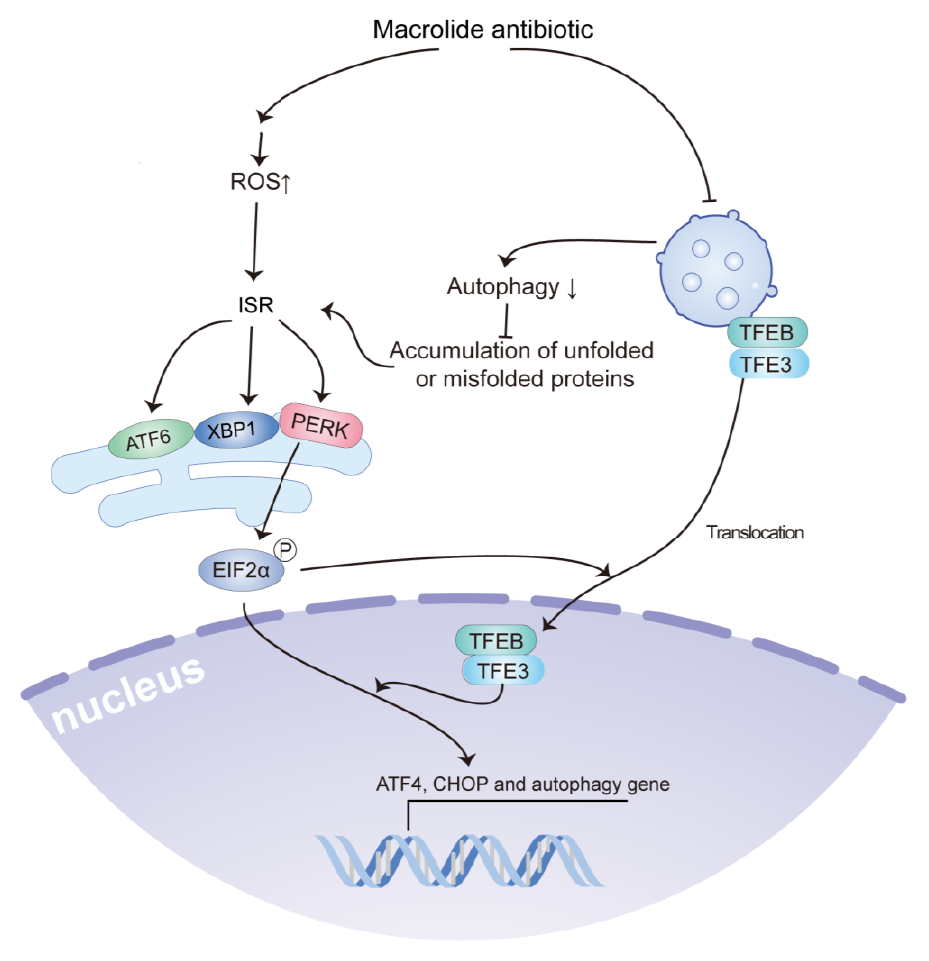
FIGURE 7: Overview of macrolide antibiotics activate the ISR. Macro- lide antibiotics inhibit lysosomal acidification, leading to the blockade of autophagic flux and the accumulation of unfolded or misfolded proteins. Moreover, they induce the accumulation of ROS. The combined accumulation of unfolded/misfolded pro- teins and ROS induces an ISR, including the activa- tion of PeIF2α/ATF4/CHOP signaling, XBP1 splicing, and ATF6 translocation, which in turn contribute to the translocation of TFEB and TFE3. Furthermore, TFEB and TFE3 are in- volved in the accumulation of LC3B-bound autophago- somes and the activation of ATF4 and